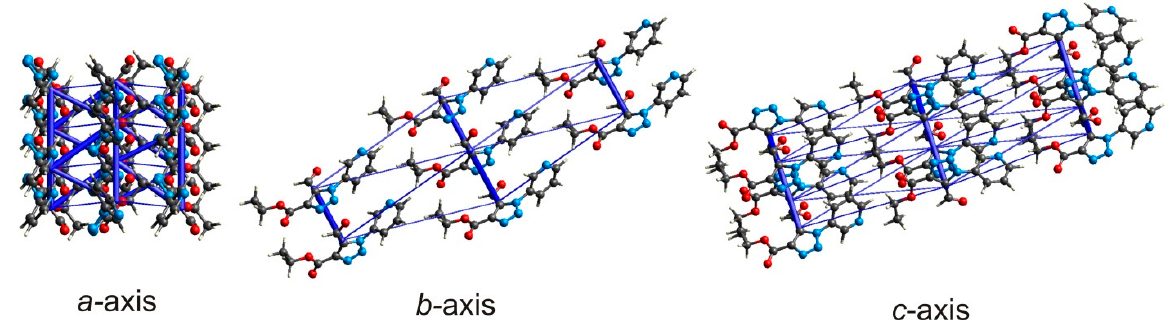
Figure 5. Energy frameworks of 4 representing the total interaction energy (blue) along the different crystallographic directions (cut-off –6.0 kJ/mol).